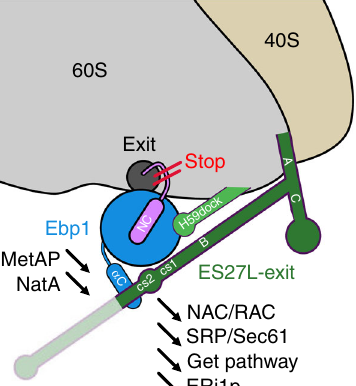
Fig. 6 Model for Ebp1 function in health and disease. The recruitment of Ebp1 (p48 isoform) to the ribosomal tunnel exit excludes NC-associated factors like modifying enzymes (MetAPs, Nats), chaperones (RAC/NAC), and targeting factors (SRP/Sec61, Get pathway). Protein biogenesis is stopped or at least slowed down as the NC is sterically hindered from exiting the ribosomal